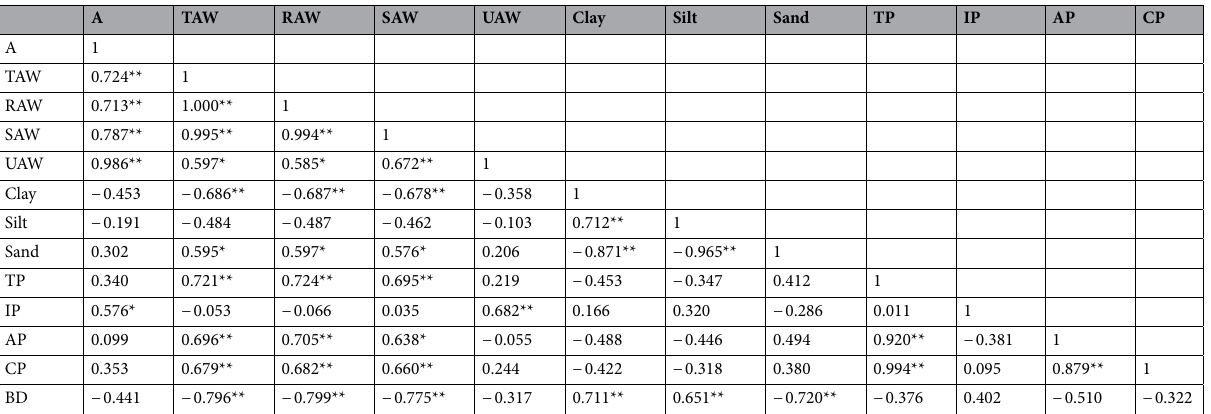
Table 2. Pearson’s correlations between soil water characteristic parameters and properties. A soil water characteristic parameter, TAW total available water content, RAW rapid available water content, SAW slow available water content, UAW unavailable water content, TP total porosity, IP inactive porosity, AP aeration porosity, CP capillary porosity, BD bulk density. *Correlation is significant at the 0.05 level (2-tailed). **Correlation is significant at the 0.01 level